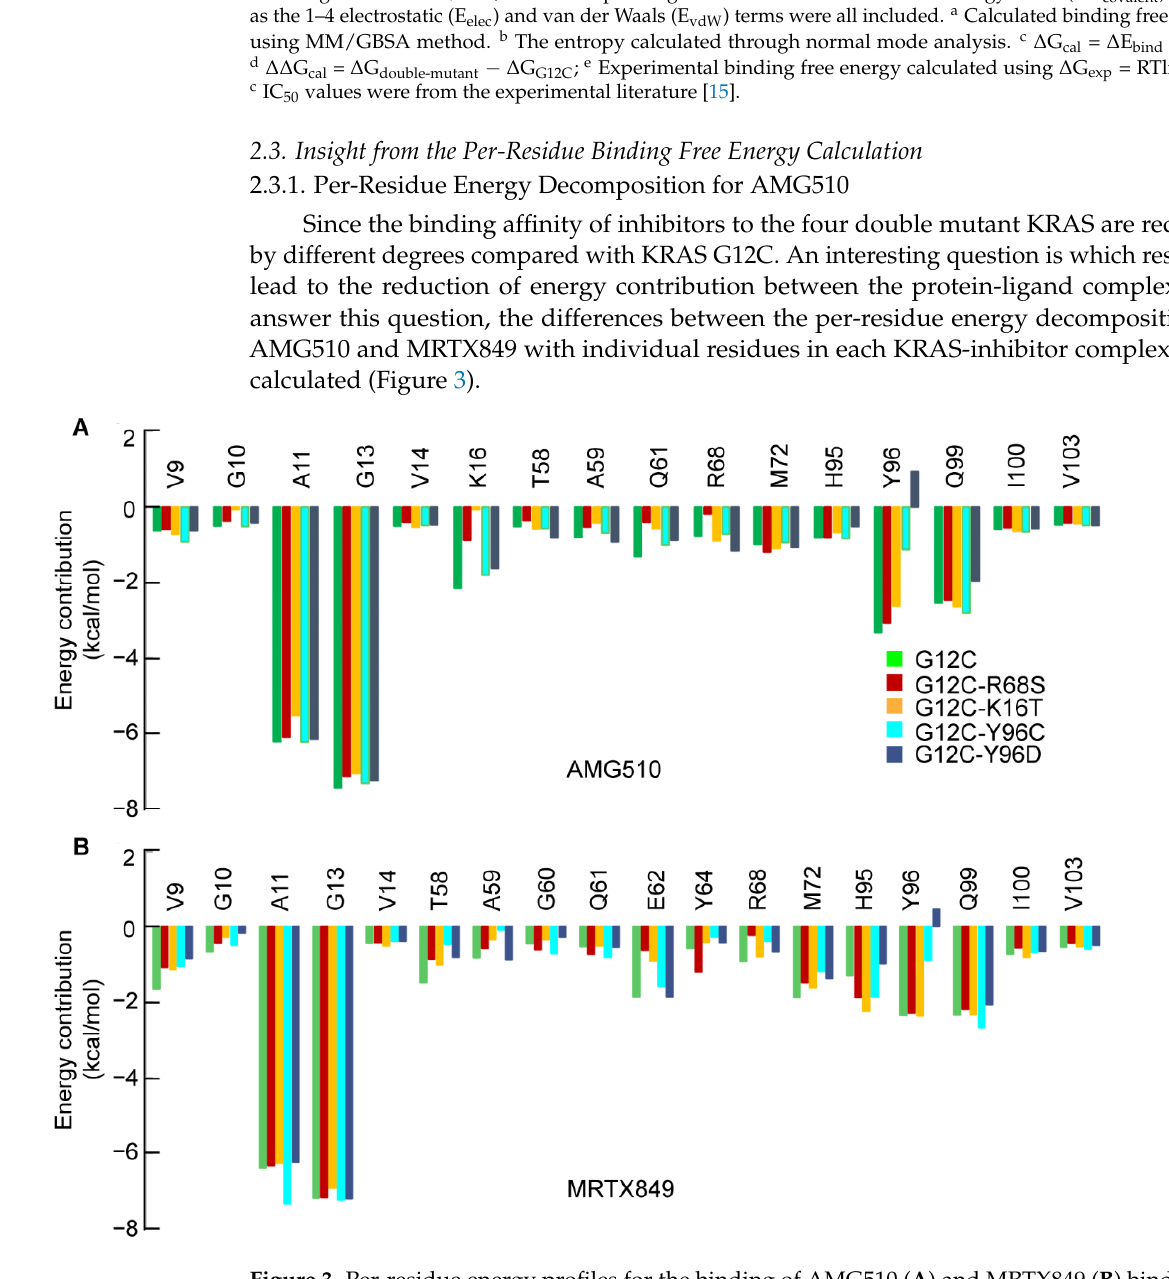
Figure 3. Per-residue energy profiles for the binding of AMG510 ( A ) and MRTX849 ( B ) binding to KRAS G12C, G12C-R68S, G12C-K16T, G12C-Y96C and G12C-Y96D, respectively. Compared to AMG510-KRAS G12C, the second-site mutation residues R68S, K16T, Y96C and Y96D are significantly decreased by 0.56 kcal/mol, 2.08 kcal/mol, 2.19 kcal/mol